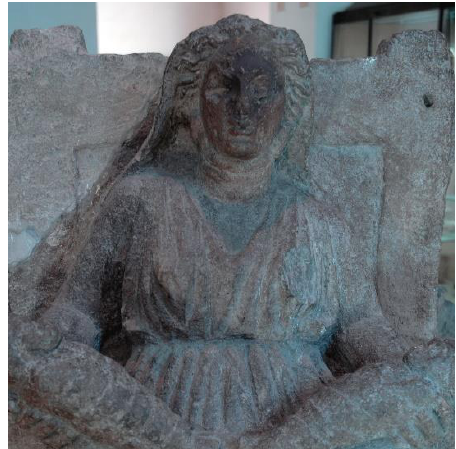
Figure 6. The Mater Matuta , details.